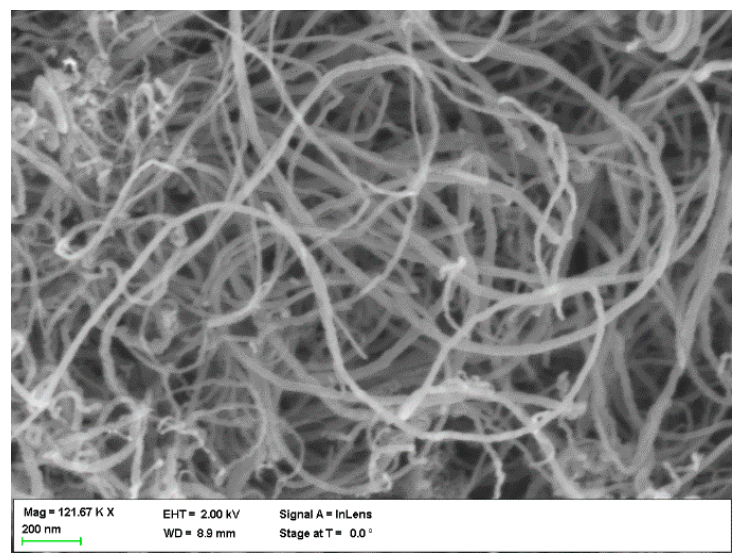
Figure 1. SEM (scanning electron microscope) micrograph of carbon nanotube functional filler.